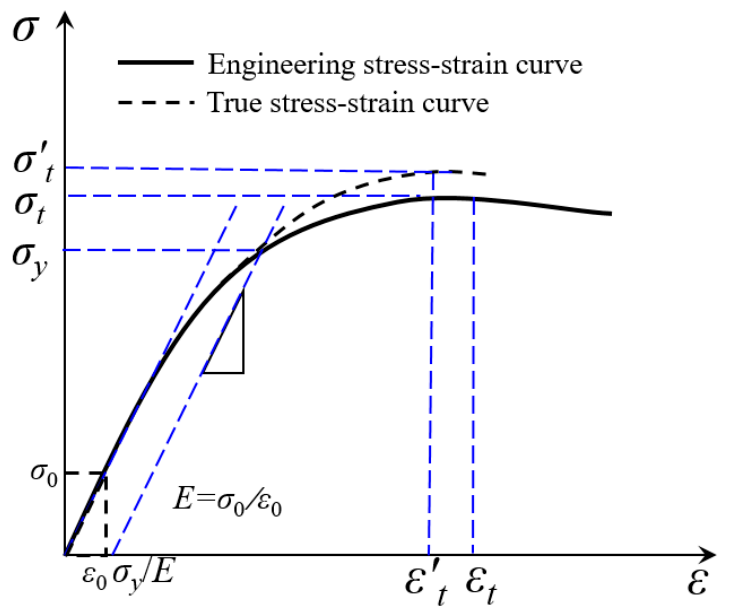
Figure 5. The power exponential constitutive model.